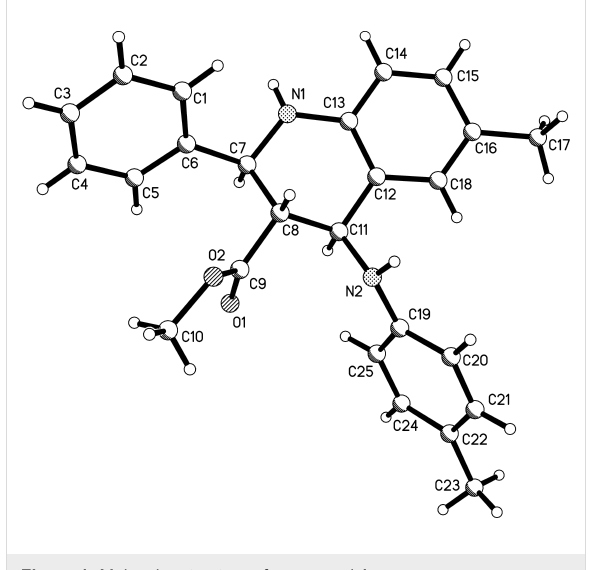
Figure 1: Molecular structure of compound 1c